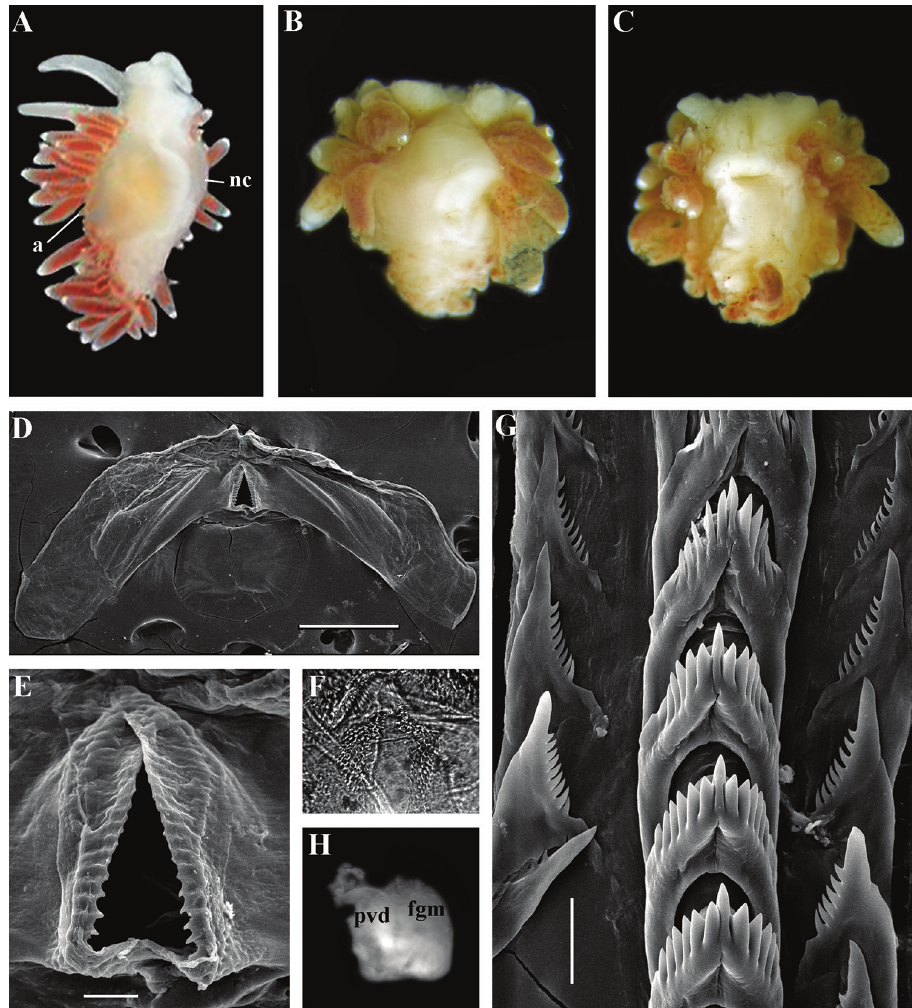
Figure 17. Borealia sanamyanae sp. n. ZMMU Op-518. Kurile Islands, Matua Island, living specimen 5 mm in length: A latero-ventral view B dorsal view (fixed) C ventral view (fixed) D jaw, SEM E details of masticatory process of jaw, SEM F details of masticatory process of jaw, light microscopy G radular teeth, posterior part H reproductive system (non-mature), light microscopy. Abbreviations: a anus fgm female gland mass nc continuous notal edge pvd prostatic vas deferens. Scale bars: D = 300 μm; E, G = 30 μm. Photos of living specimens by N.P. Sanamyan, other photos and SEM images by A.V.